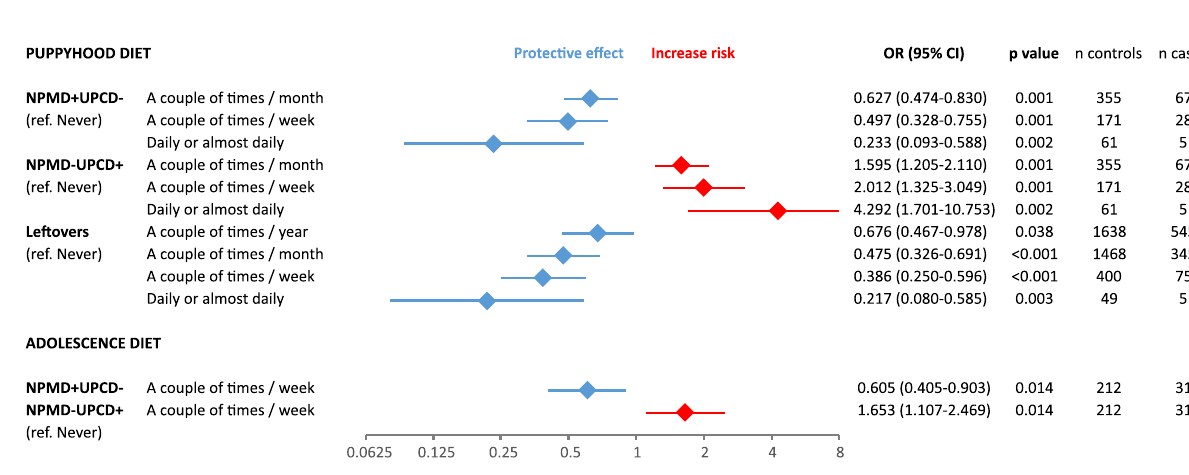
Figure 2. Odds ratios (OR) of the significant ( p < 0.05) associations between the puppyhood and adolescence diet feeding frequencies and the incidence of chronic enteropathy (CE) in adult dogs based on multivariate logistic regression analyses (adjusted for gender). The inverse association of NPMD (non-processed meat-based diet) and UPCD (ultra-processed carbohydrate-based diet) means that owners gave both foods in a reciprocal manner so that when the amount of NPMD given for the dog was high, the amount of UPCD given was low and vice versa. Red color denotes increased risk, blue color denotes protective effect, CI = confidence interval, ref =